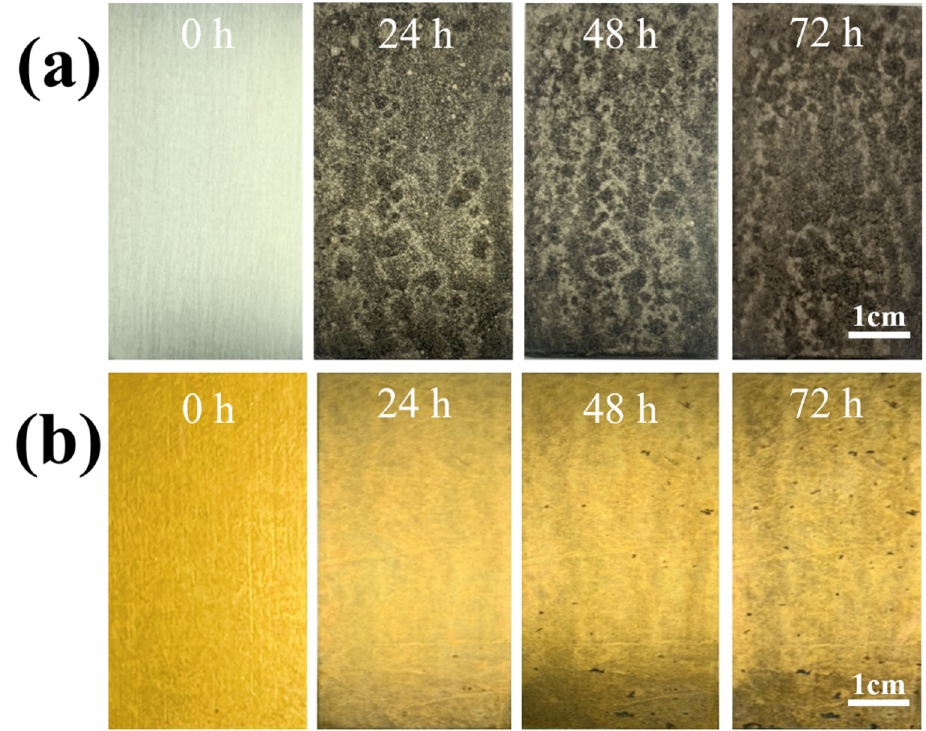
Figure 9. Optical images of ( a ) bare LZ91 and ( b ) the conversion-coated sample after 72 h SST.